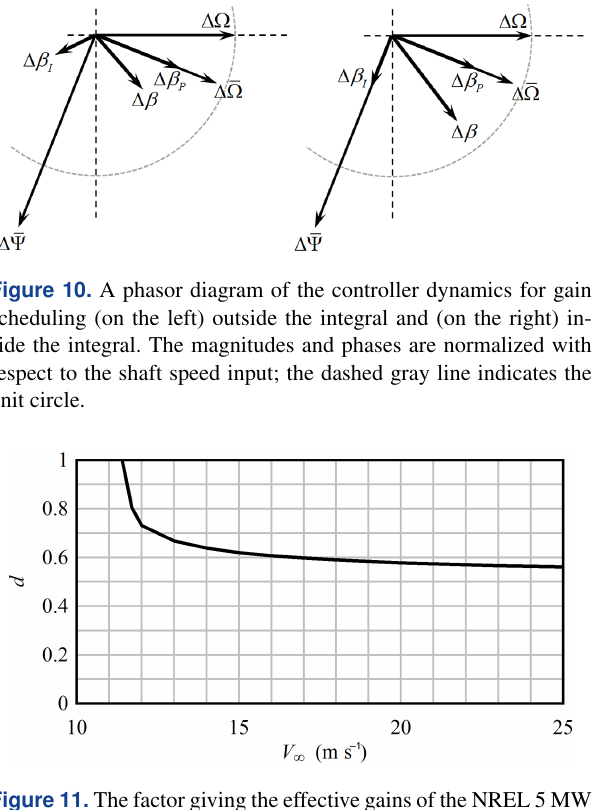
Figure 11. The factor giving the effective gains of the NREL 5 MW controller, with respect to the nominal values, which have been scheduled outside the